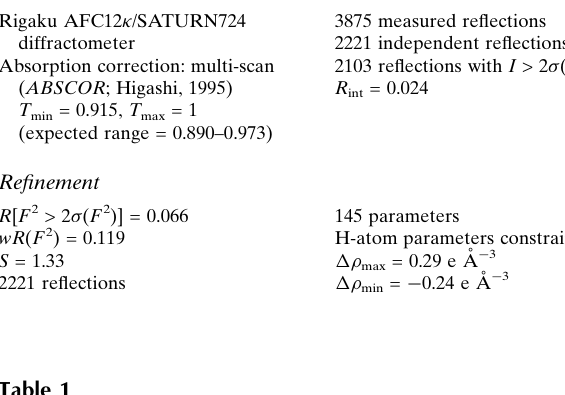
Hydrogen-bond geometry (A˚ , (cid:2)